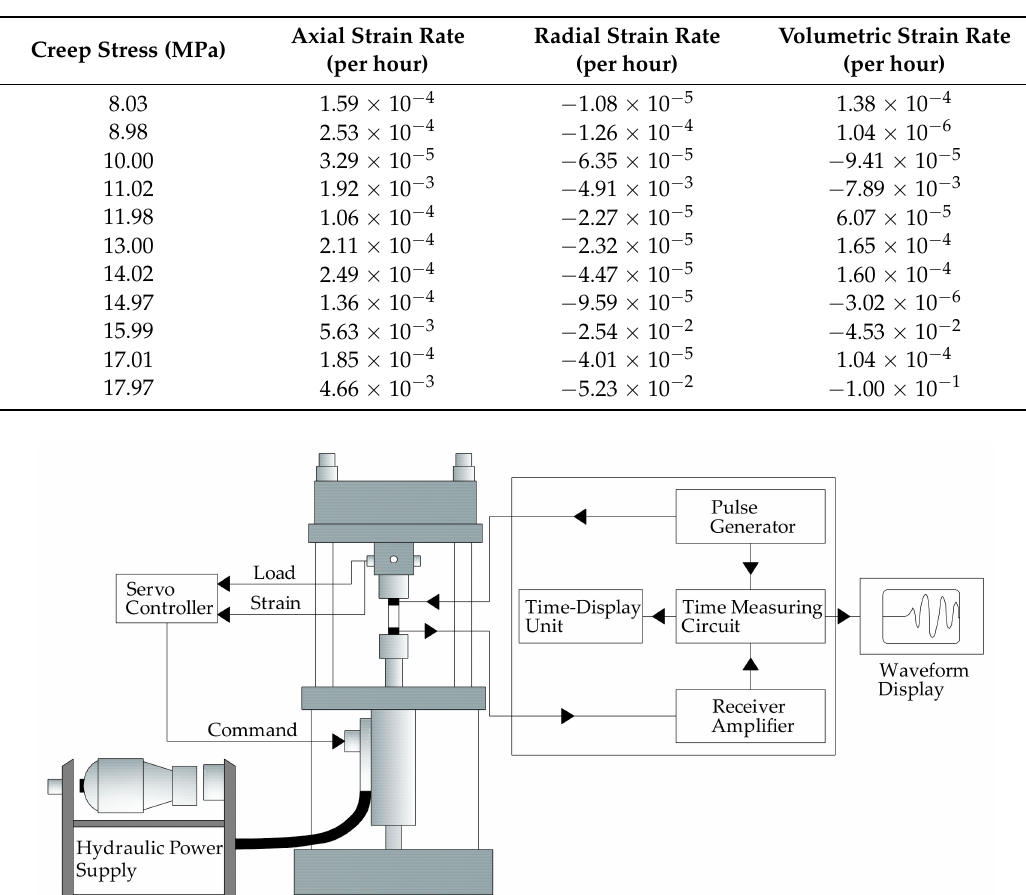
Table 1. Applied stresses and secondary strain rates for the creep compression tests.